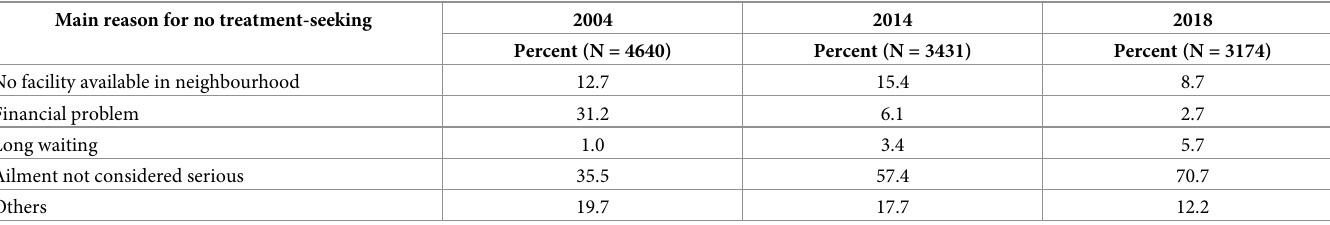
Table 5. Reasons (percentage distribution) for no treatment-seeking in three rounds of NSS, India, 2004–2018. Main reason for no